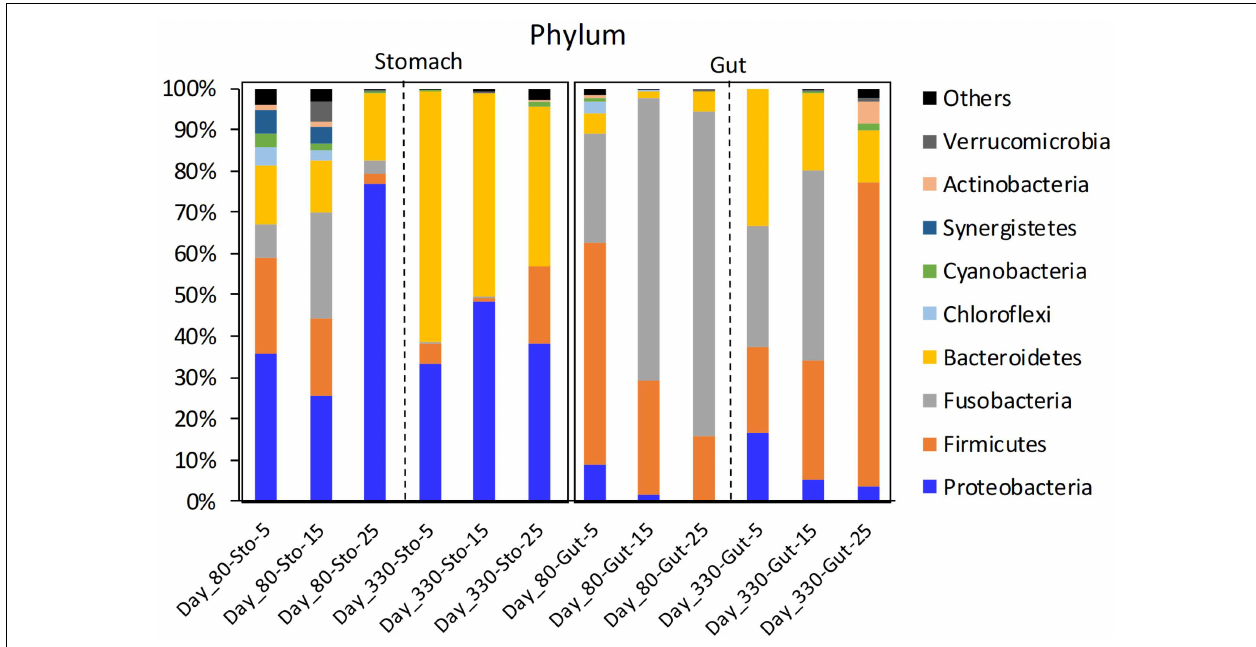
FIGURE 1 | The mean relative abundance of the phylum in giant salamander stomach and gut microbiome under different temperatures. Sto, stomach content sample; Day 80, 80 days after acclimation; Day 330, 330 days after acclimation; Others, the total of the low relative abundance